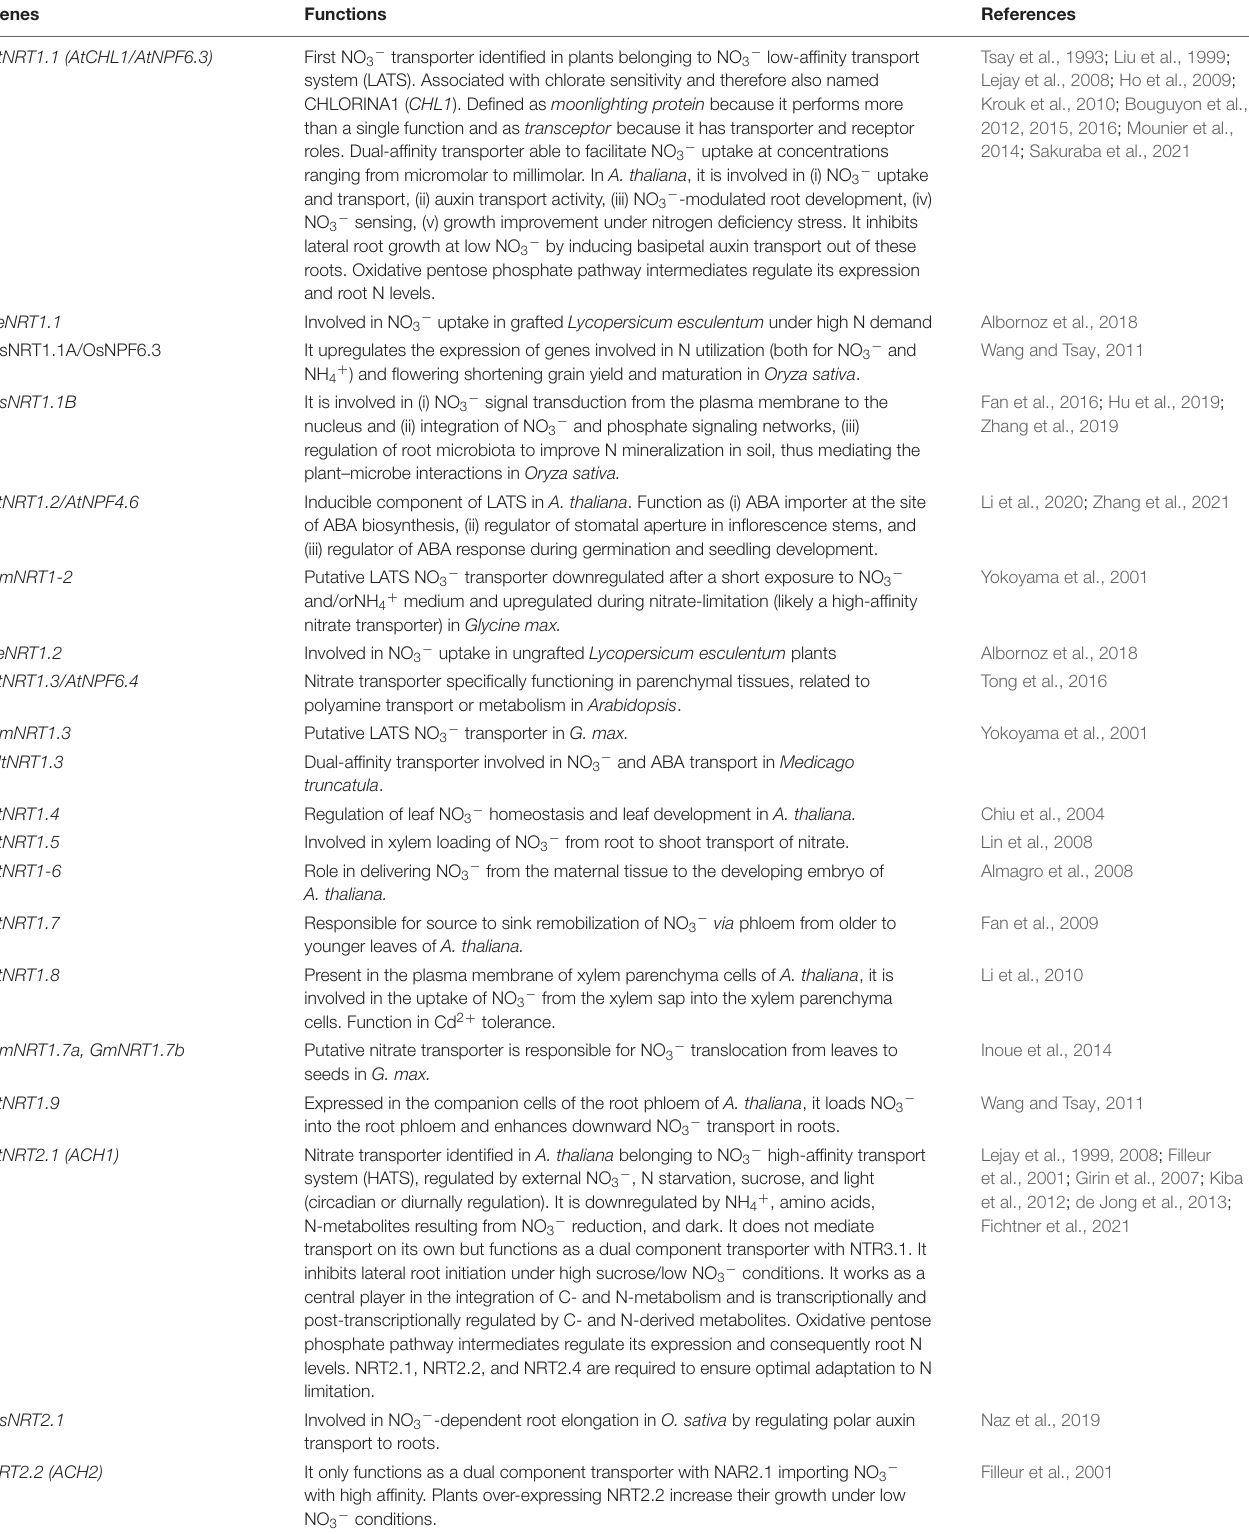
TABLE 1 | Genes related to N uptake translocation and assimilation. Genes